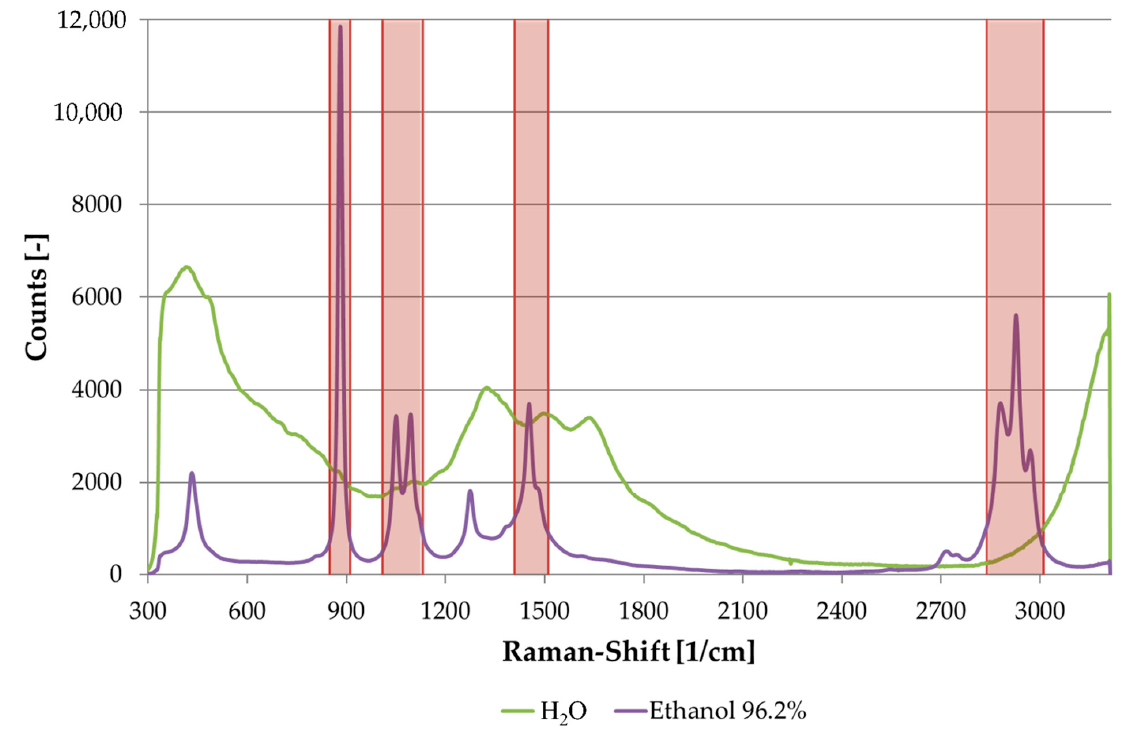
Figure 3. Raman spectra of water and ethanol with evaluated intervals.